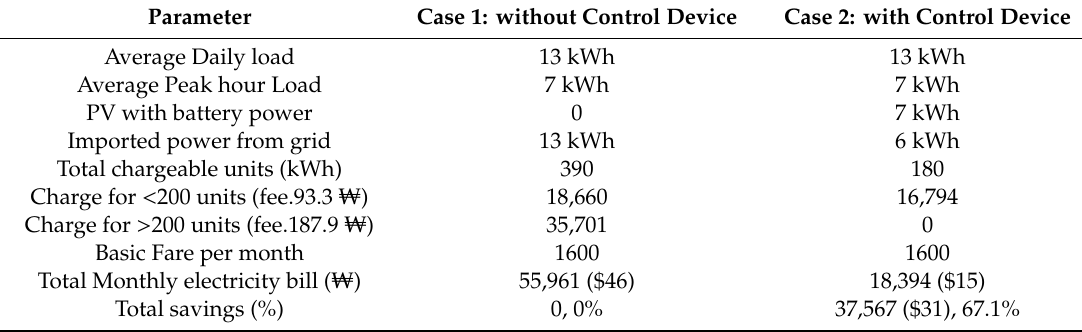
Table 4. Electricity tari ff details with and without using control